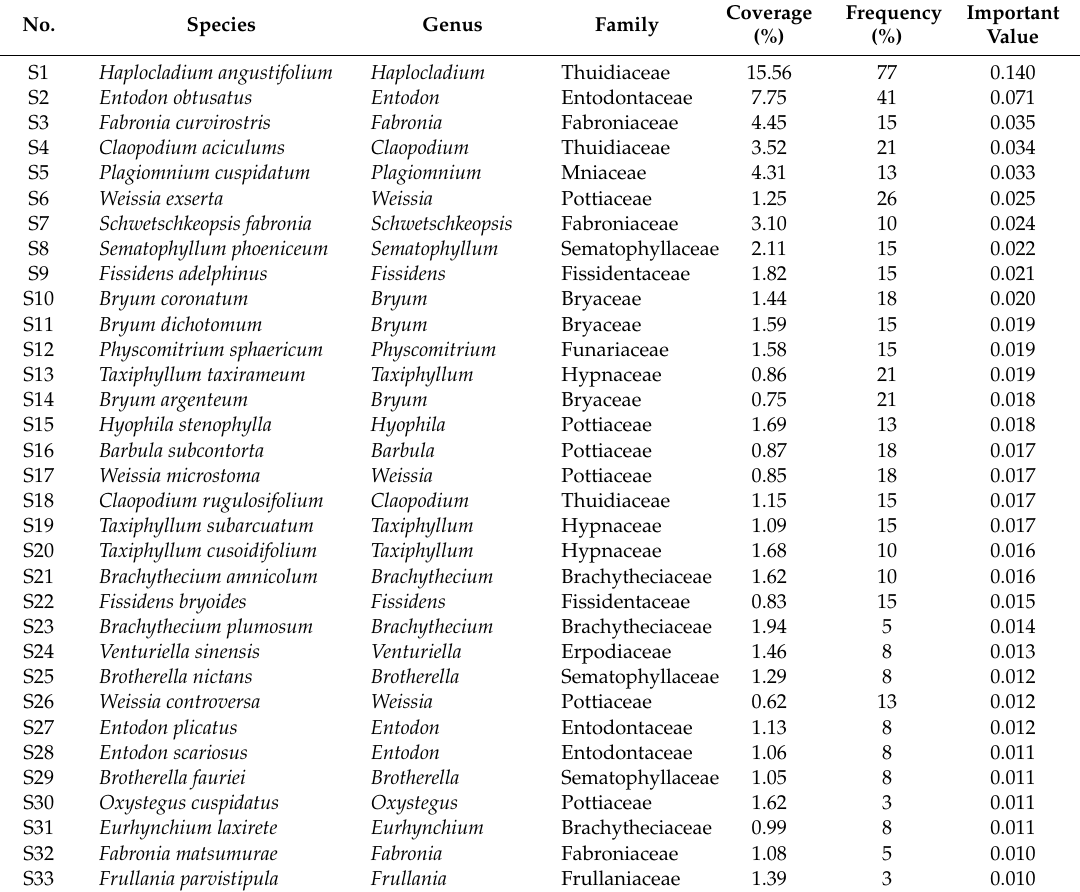
Table 1. Dominant bryophyte species and their important